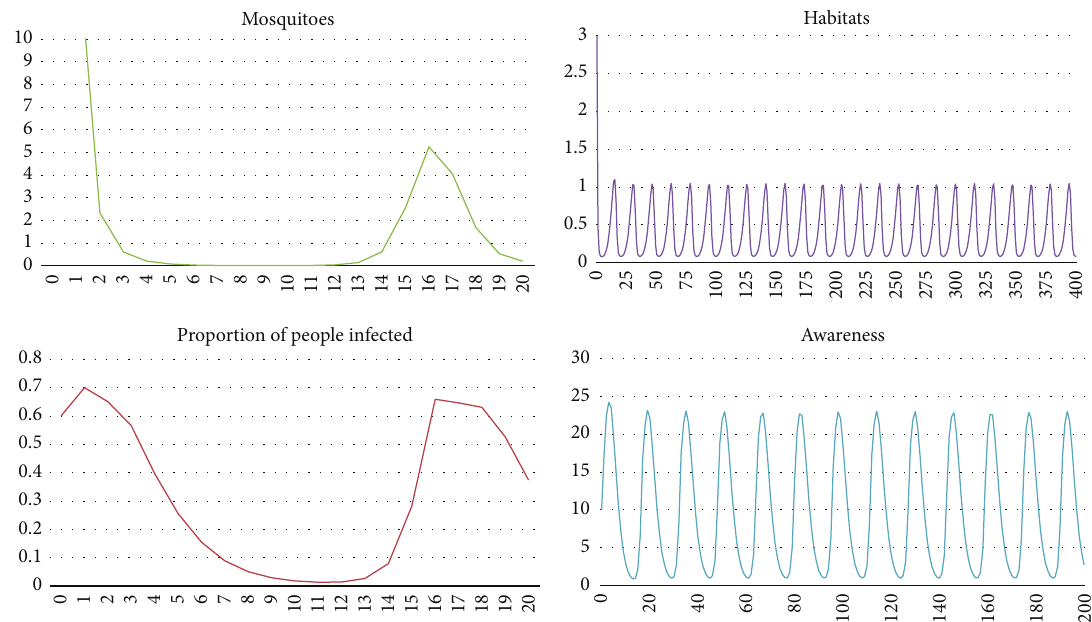
Figure 3: The above graph is generated with parameter values 𝑎 = 0.5 , 𝑝 = 0.5 , 𝑏 = 5 , 𝑐 = 0.6 , 𝑙 = 0.5 , 𝑖 = 0.5 , 𝑟 = 0.5 , and 𝑓 = 20 (the parameters are placed in the region where 𝑏 > (1 − 𝑐)(1 − 𝑙) ). One can see that the solutions display oscillatory behavior for smaller values of 𝑟